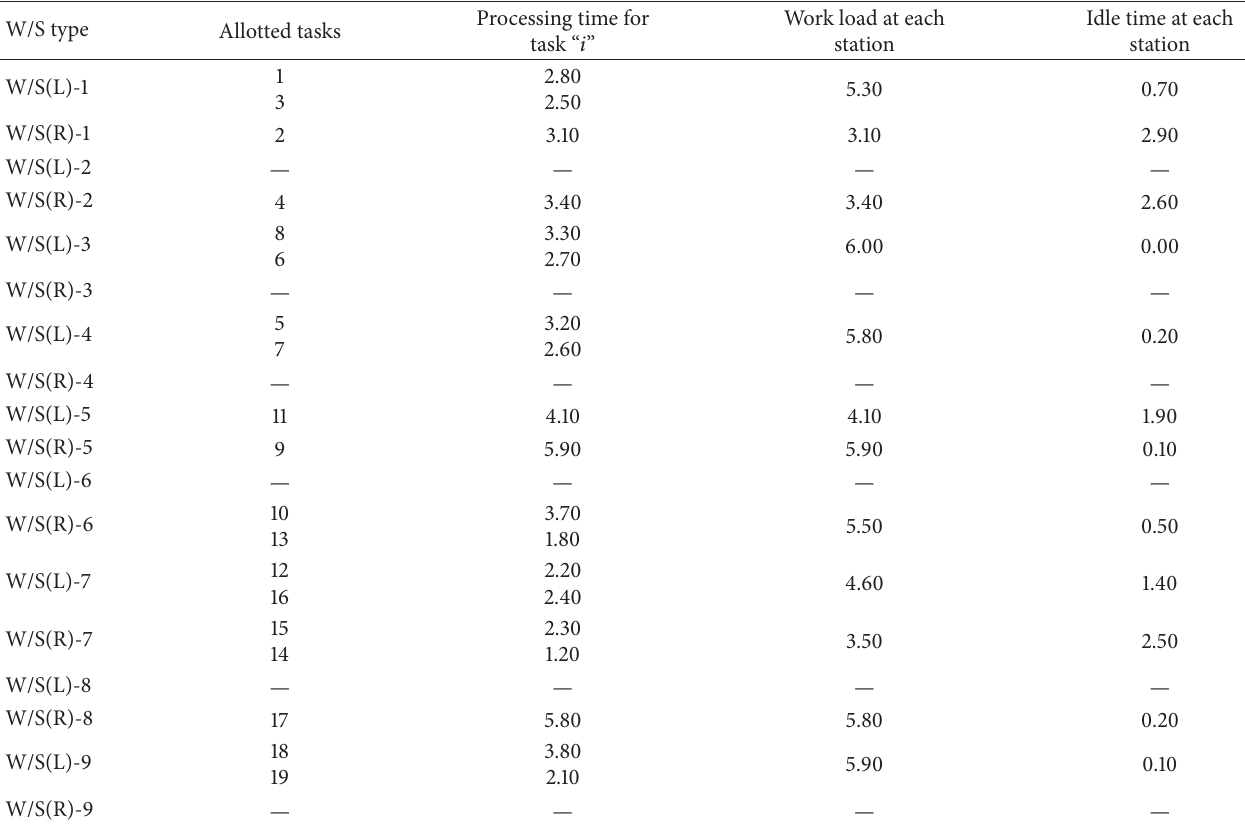
Table 7: Allocation of tasks for 11th sssignment of P19 (CT = 6